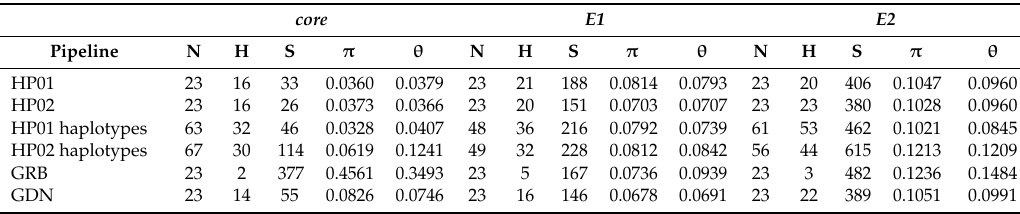
Table 5. Comparison of the e ff ect of consensus generation on estimated genetic diversity across the empirical HCV